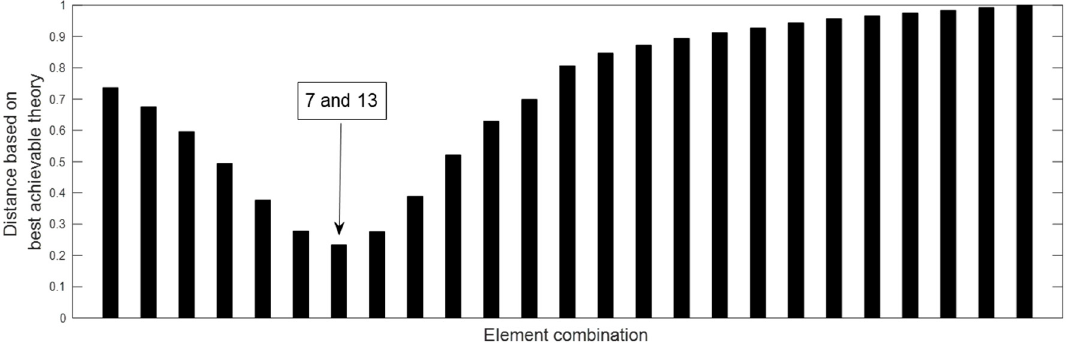
Figure 4. Distances for the element combinations when elements 7 and 13 are damaged (no noise).